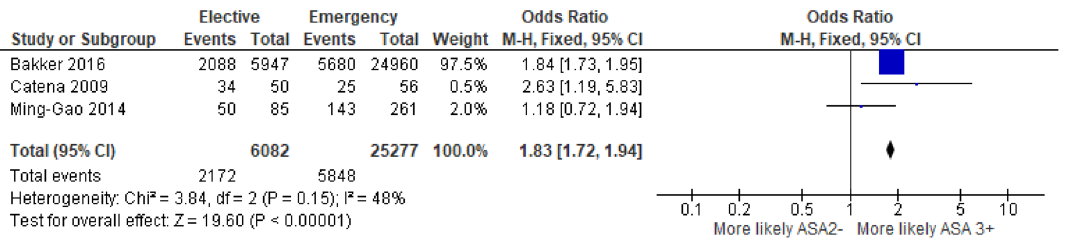
Figure 14. Association between ASA Grade and emergency presentation—Forest